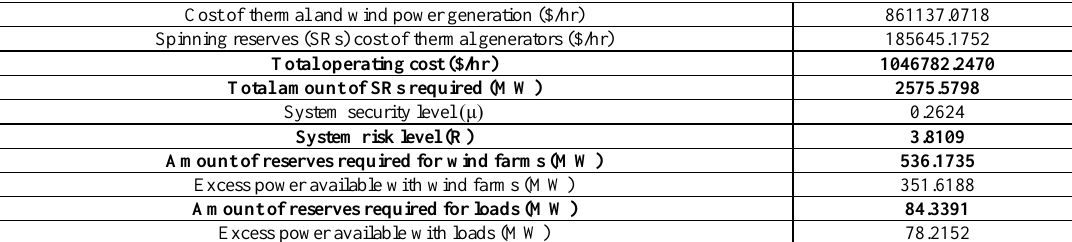
Table 3. Objective function values for Case Study